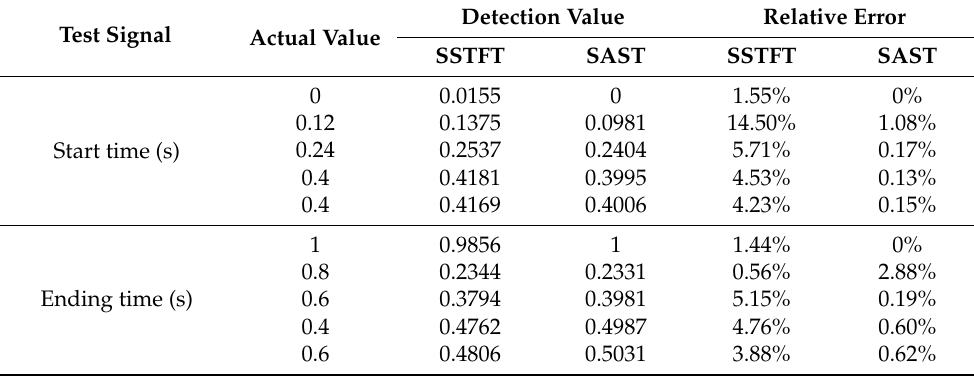
Table 2. Accuracy of time detected by the two